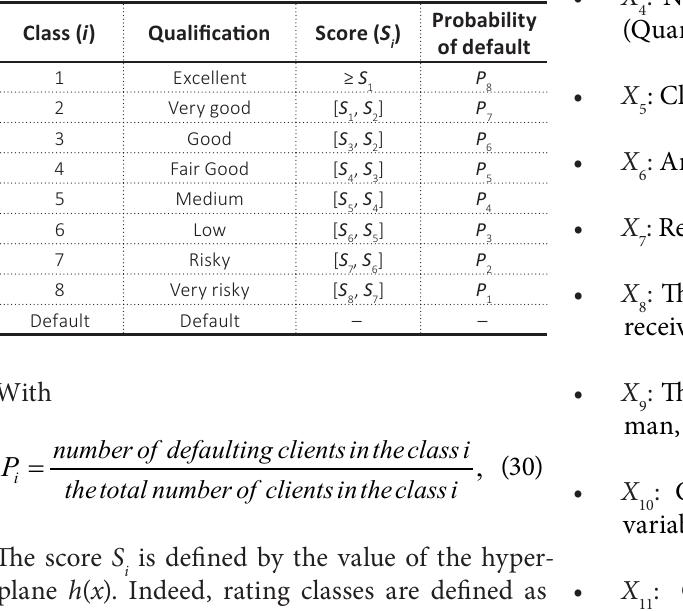
Table 1. Design of the scoring